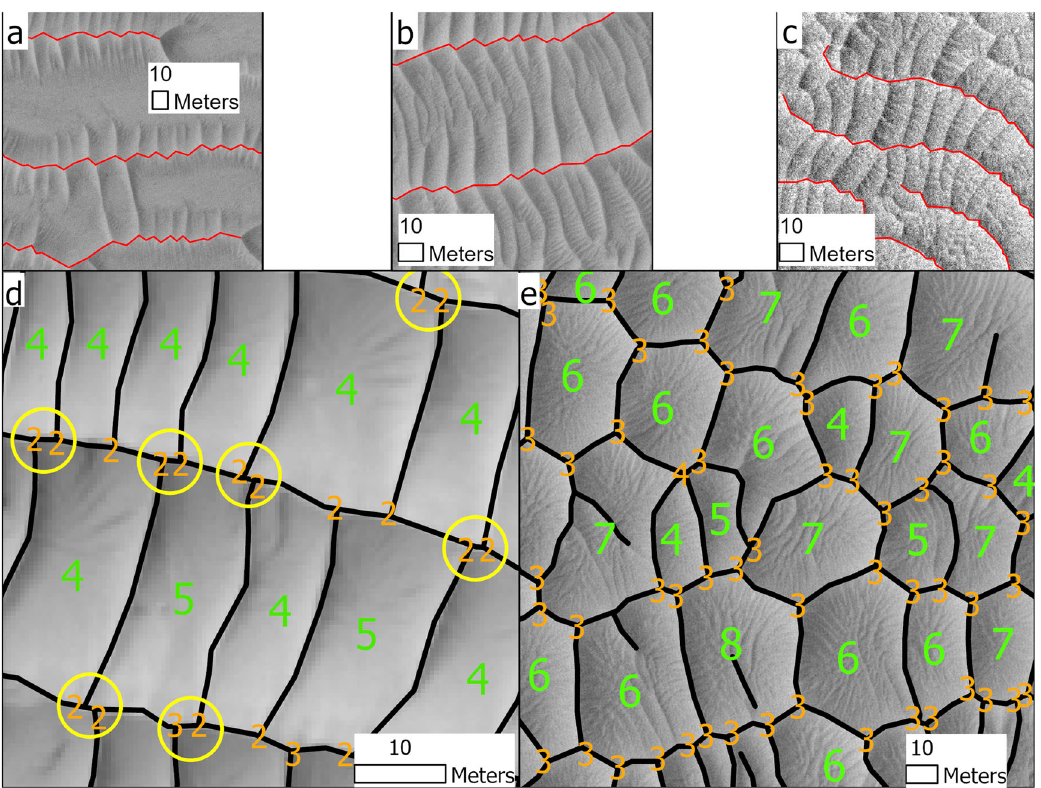
Fig. 2 Scalloping of primary ridges and metrics for differentiating networked morphologies. a – c Note that nearly every kink (annotated in red) in the primary ridges corresponds to the terminus of a secondary ridge, and that the kinks form ~120° angles. Sequence left to right ( a – c ) represents an evolution towards more well-developed secondary ridges (a: ESP_064811_1670; b: ESP_064811_1670; c: ESP_065223_1855). d , e manually traced ridge crests in black, vertices per cell in green, and nodal degree in orange. d Rectangular networked TARs with a median of four vertices per cell, and a nodal degree of two or three when minor misalignments occur (circled in yellow) (ESP_017661_1545). e Hexagonal networked TARs with a median of six vertices per cell. Hexagonal networked TARs almost exclusively have a nodal degree of three